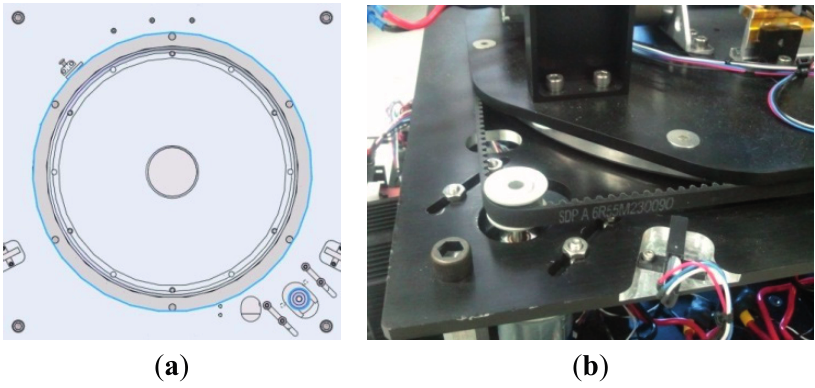
Figure 9. ( a ) Cross section view of the turntable in the virtual model; ( b ) Actual image of the interaction of pulley and belt.